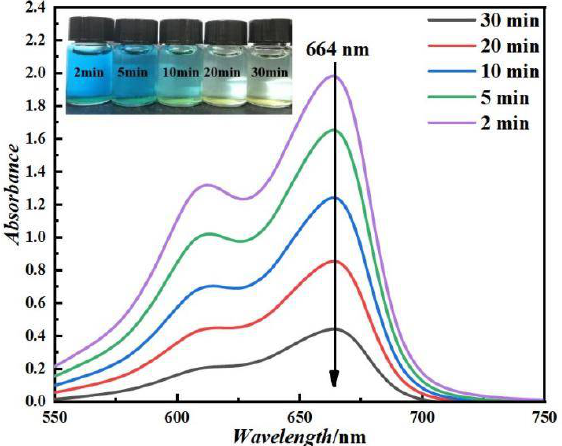
Figure 1. Absorbance of MB at different times.